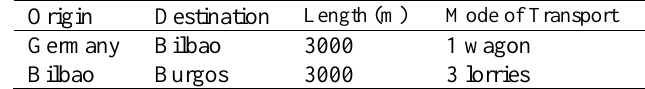
Tabl 7. Optimal so tion for the urgos